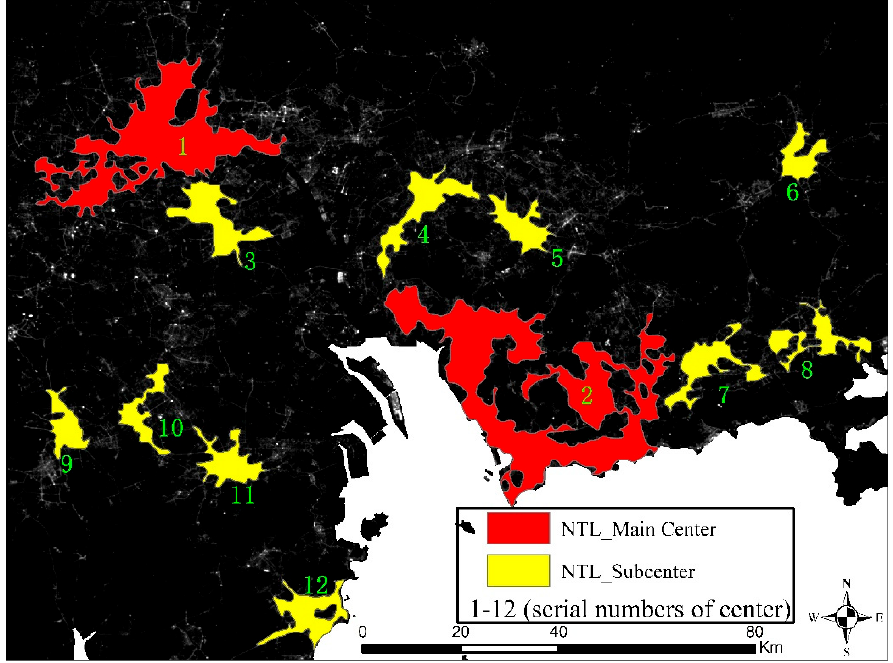
Figure 7. Main and subcenters of PRD identified by NTL data.